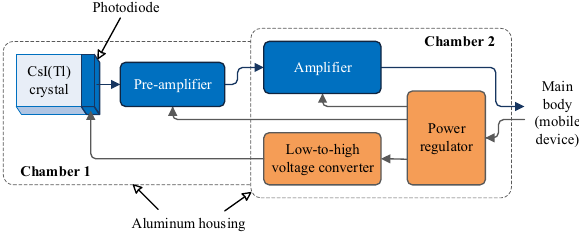
Figure 3. Structure of the secondary detector module of the CsI(Tl) scintillator.